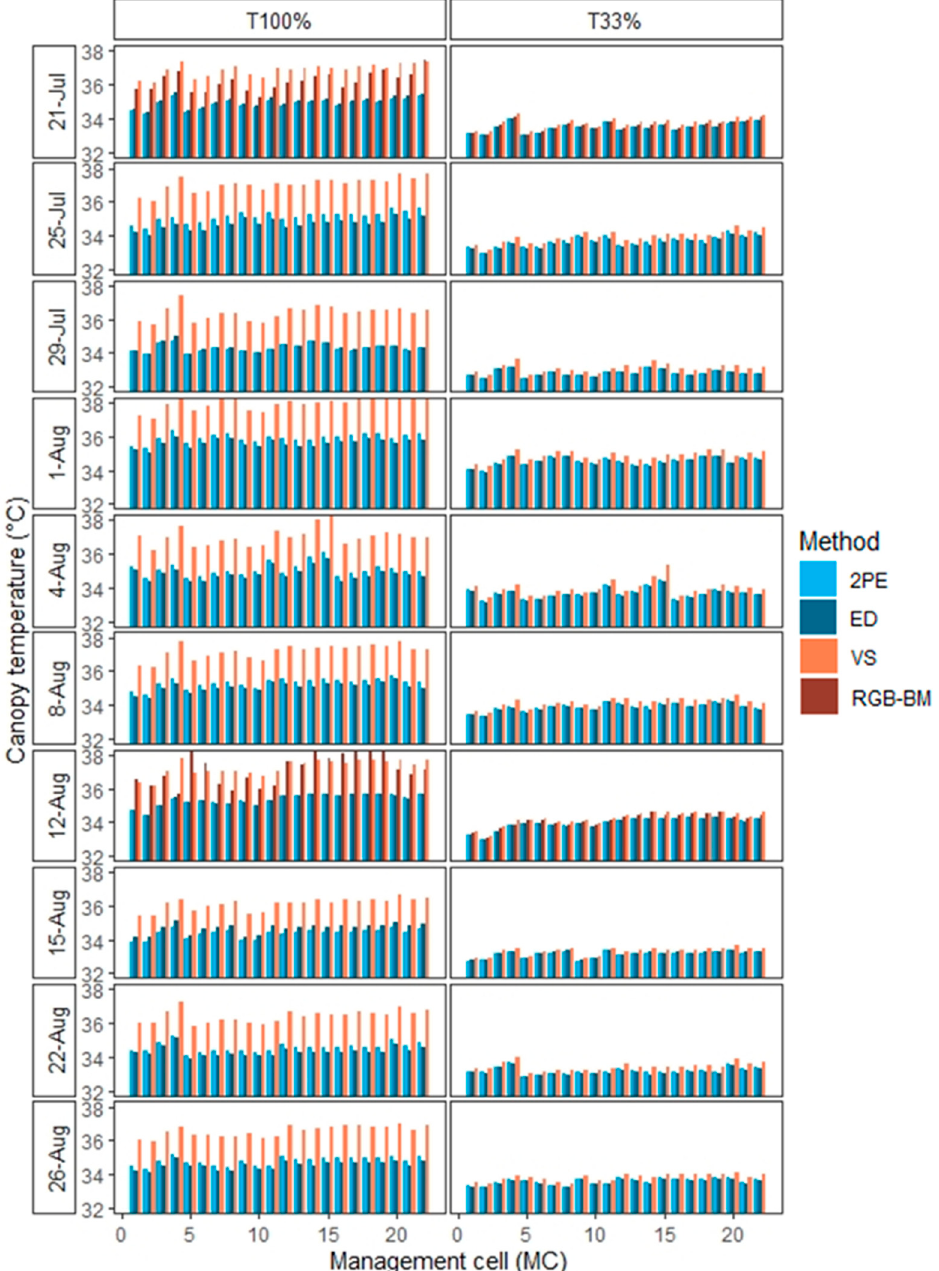
Figure 6. Canopy temperature (°C) calculated by the average 100% (T100%) and by the average of the coolest 33% (T33%) of canopy pixels per management cell (MC) between 21 July and 26 Aug 2019 for the canopy extraction methods: 2-pixel erosion (2PE) (turquoise), edge detection (dark blue), vegetation segmentation (VS) (coral), and RGB binary masking (RGB-BM) (brick red).